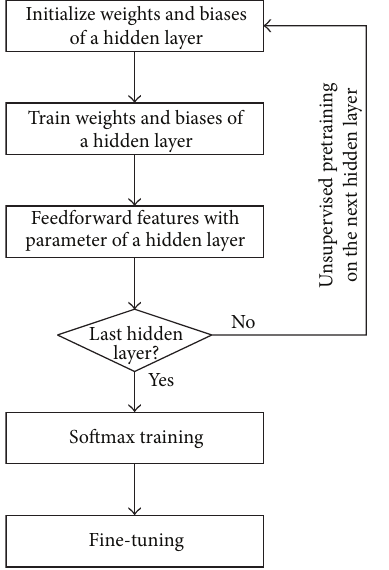
Figure 10: Summary of DLN training procedure.